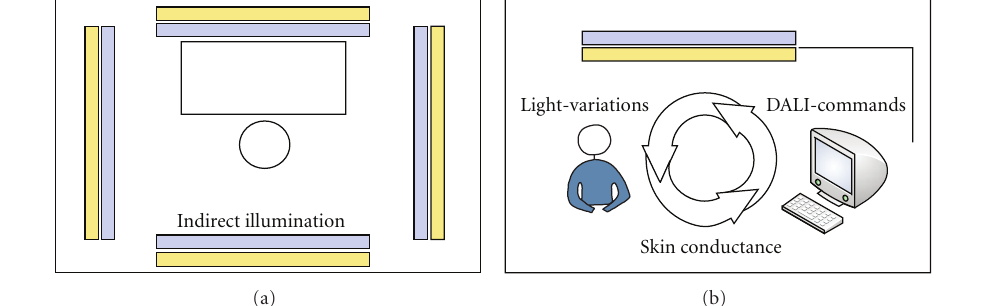
Figure 7: Four concentration games.